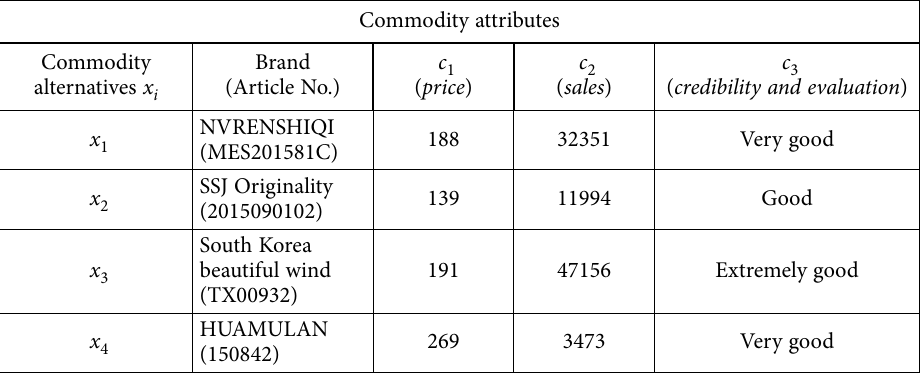
Table 1. Commodity attribute values (source: the data is from www.taobao.com) Commodity